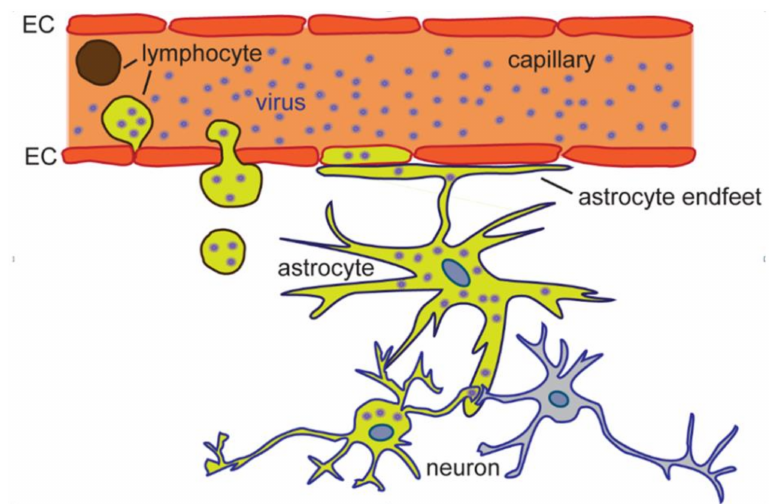
Figure 1. Astrocytes are among the first cells to be infected in the central nervous system (CNS). Viruses (denoted as dots) that circulate within blood vessels can enter the CNS by crossing the blood–brain barrier, which is composed of endothelial cells (EC). The endfeet of astrocytes closely align ECs, thus making astrocytes very receptive to virus uptake. Virus-infected cells are highlighted in